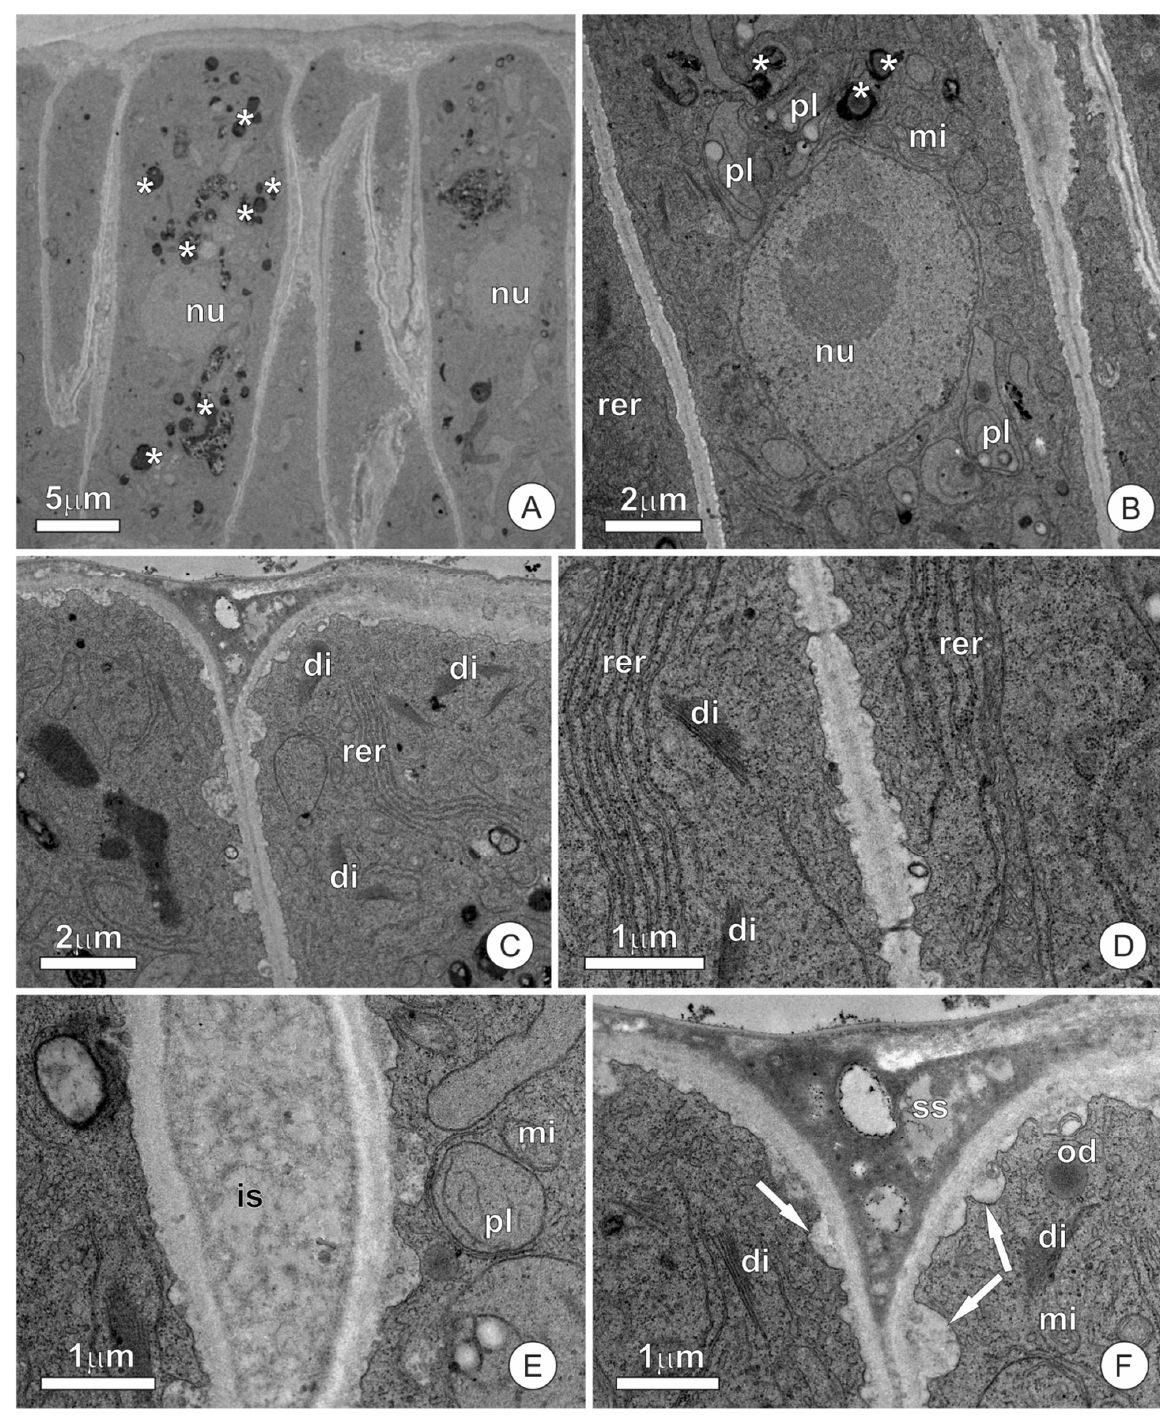
Figure 5. Ultrastructural aspects of the colleters of O. castaneifolia : ( A ) Overall aspect of the secretory epidermal cells showing dense protoplast and numerous osmiophilic inclusions (*); ( B – D ) Secretory cells showing large nuclei and organelle-rich cytoplasm with numerous mitochondria, plastids, and segments of the rough endoplasmic reticulum. Note oil droplets within the plastids and dispersed throughout the cytosol along with osmiophilic inclusions (*) in ( B ); ( E , F ) Details of the sinuous plasma membrane of secretory cells. Note the formation of irregular periplasmic spaces (arrows) and the accumulation of flocculated material within intercellular spaces and the subcuticular space. di = dictyosome, is = intercellular space, mi = mitochondria, nu = nucleus, od = oil droplet, pl = plastid, rer = rough endoplasmic reticulum, ss = subcuticular space.